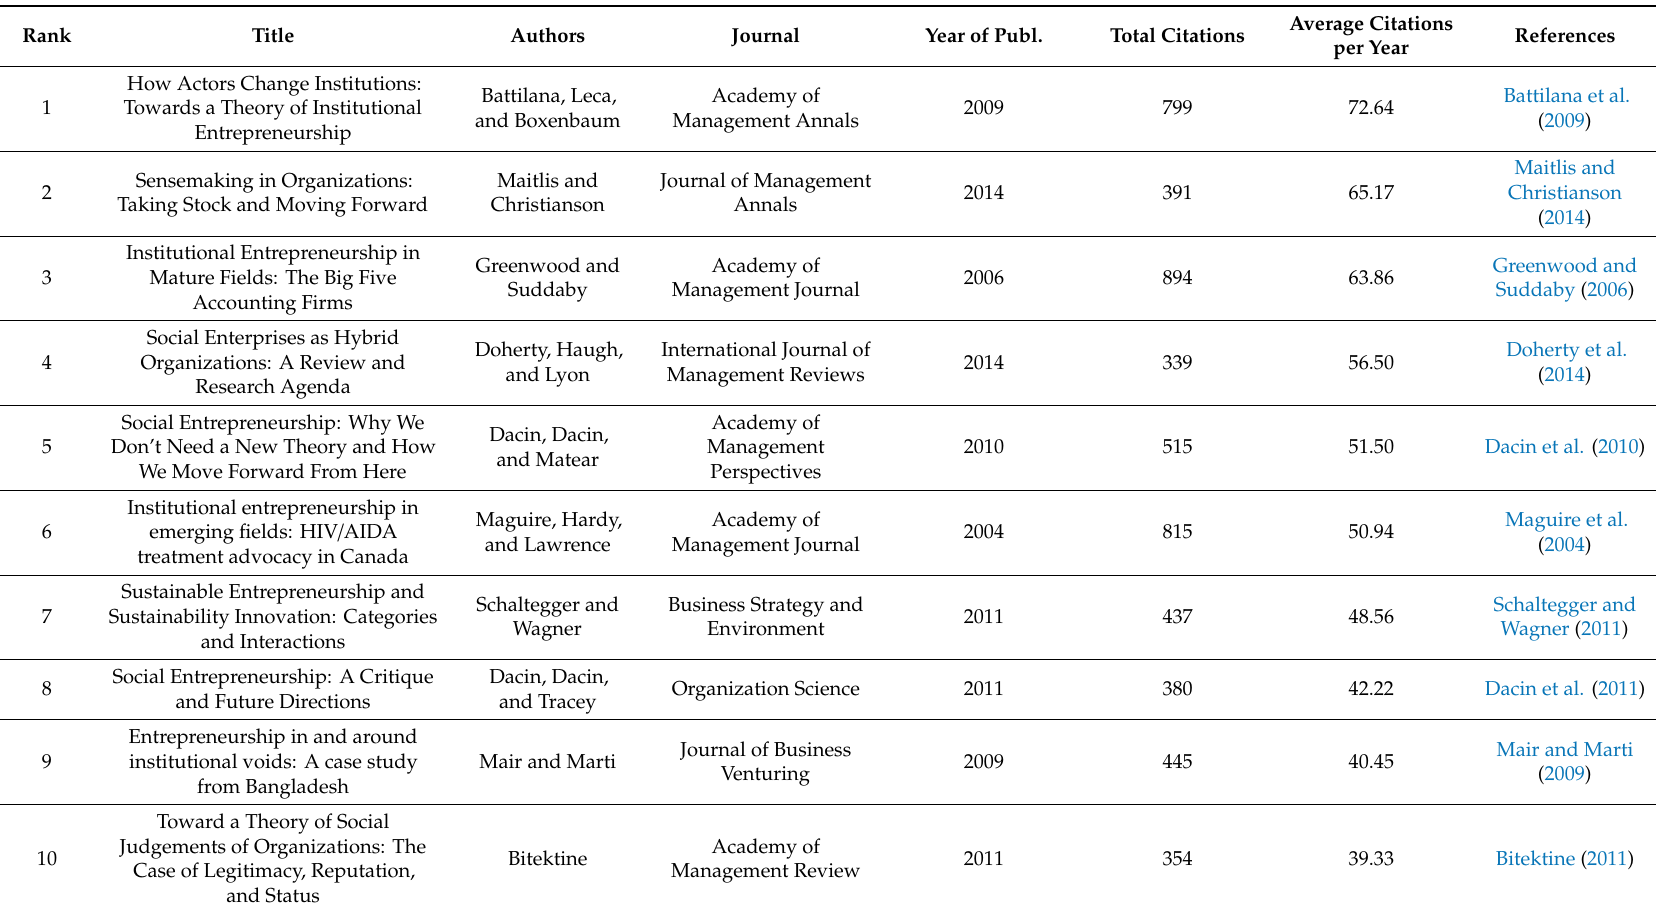
Table 7. Most influential